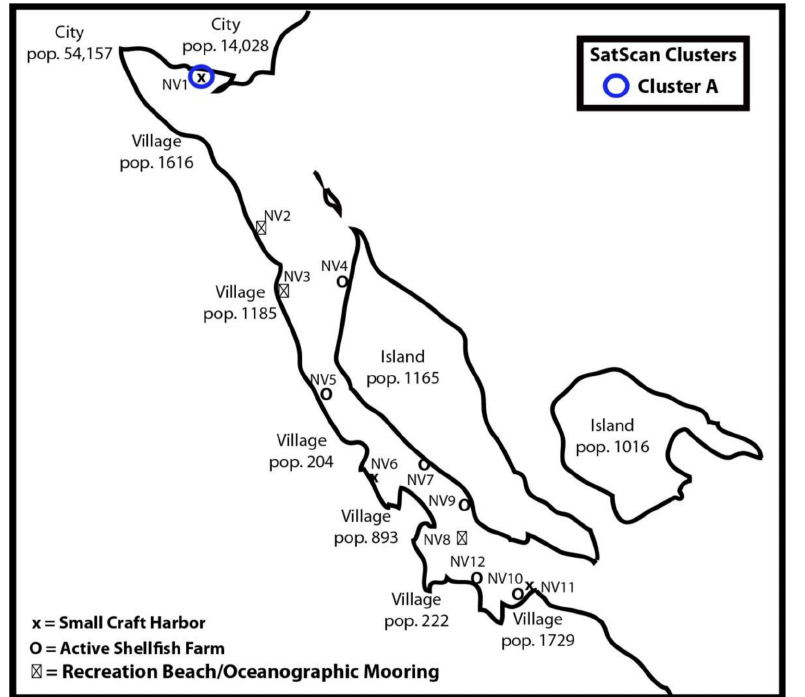
Viruses 2022 , 14 , x 4 of 10 Figure 2. Schematic representation of sample sites within the Sound. One significant (cluster A: blue circle) was identified in the Sound using SatScan v9.6.1. Sentinel oyster deployment locations are marked as NV1–NV12. Locations marked as “o” are active shellfish farms, “x” are small-craft harbors, and